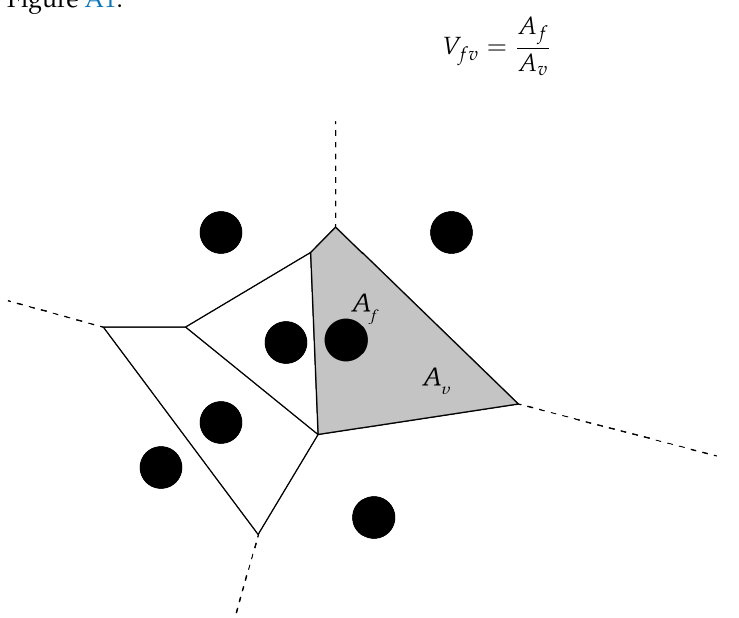
Figure 1. Voronoi tessellation around fibre